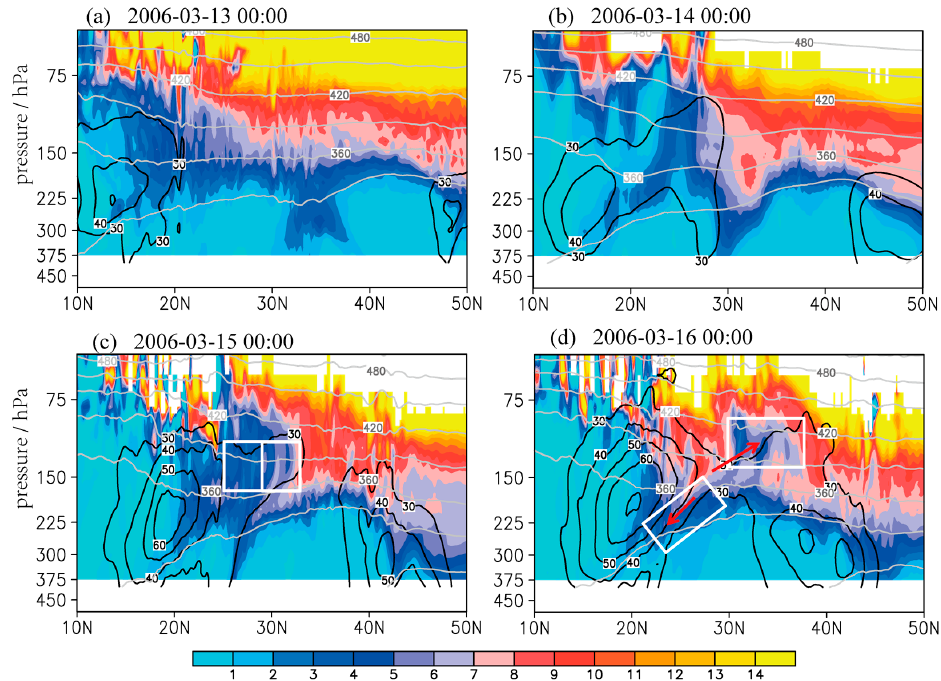
Figure 7. Vertical sections along ( a ) 80°E, ( b ) 90°E, ( c ) 100°E and ( d ) 110°E, from 13 to 16 March 2006, respectively, of PV (shading; unit: PVU), zonal wind (black contours; unit: m s − 1 ), and potential temperature (grey contours; unit: K). The white rectangles illustrate the two clustering locations of air particles.